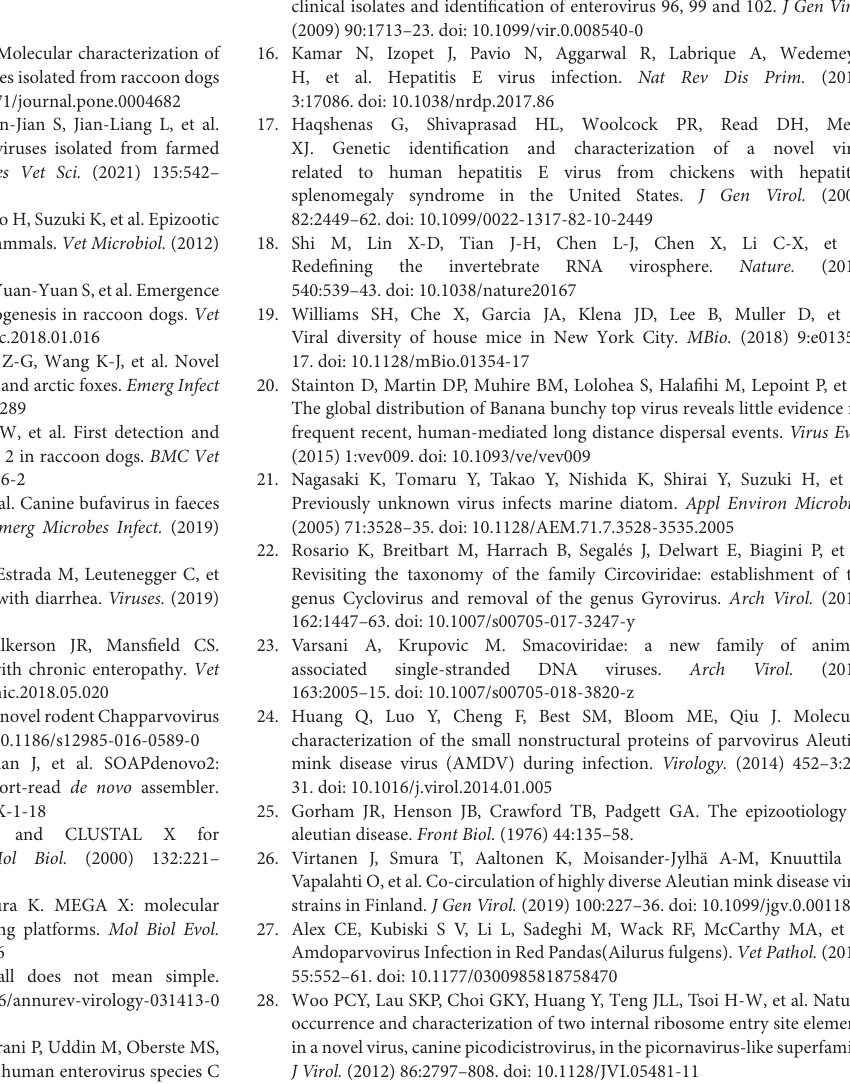
VP2. The percent identity between RADM and other strains was marked with red. Supplementary Table 1 | The Summary of library information of raccoon dogs. Supplementary Table 2 | The Sequence numbers of animal virus in different libraries of this